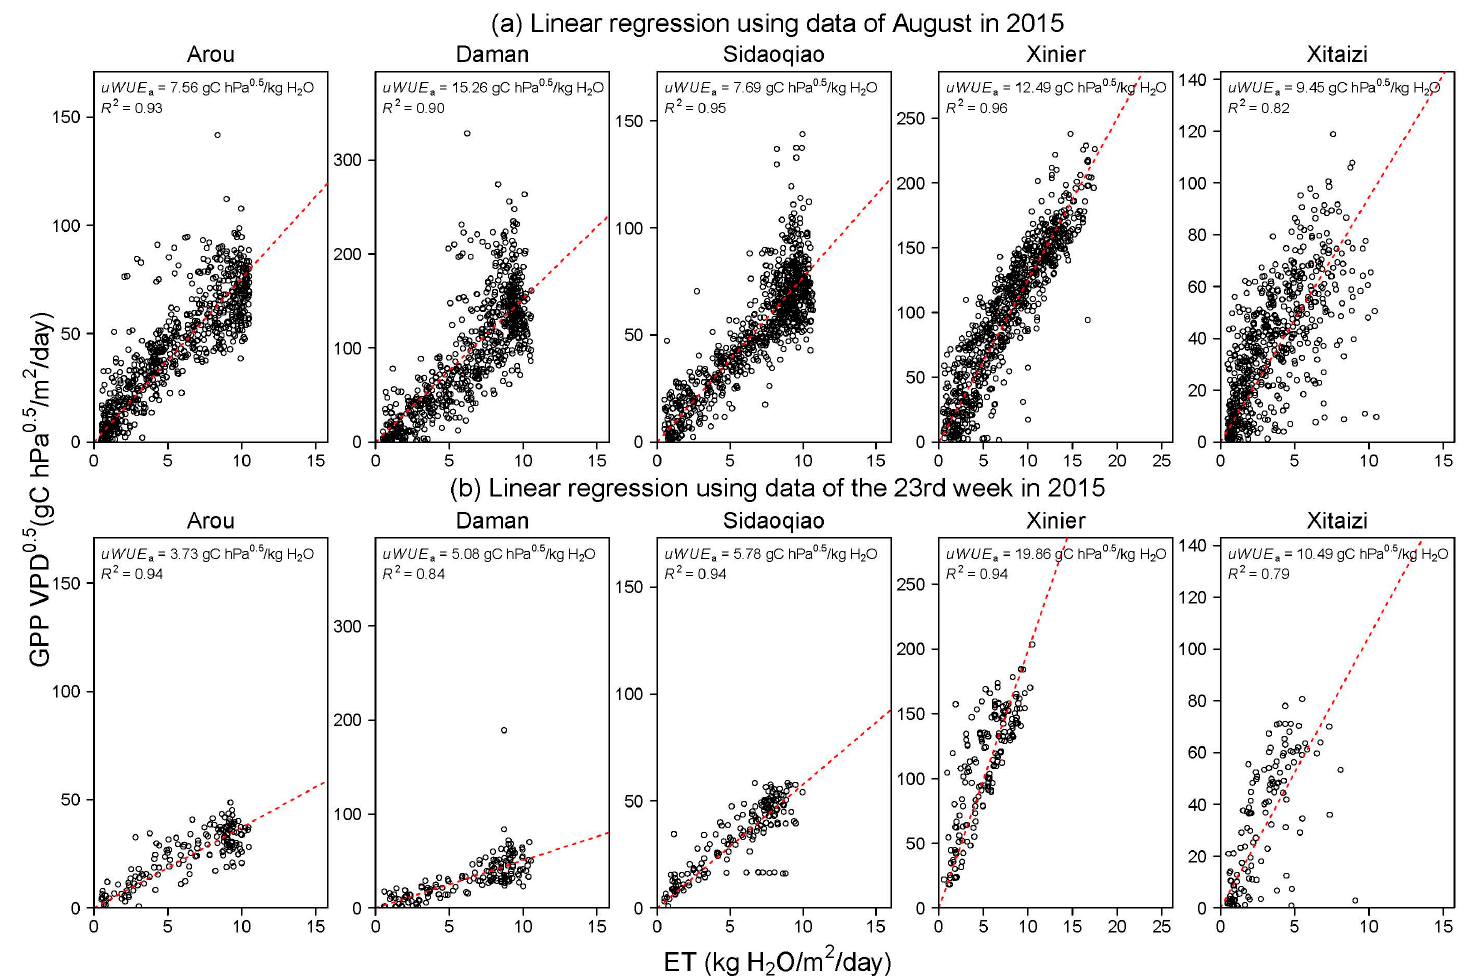
Figure 4. Linear regression using the half-hourly data for each site on a monthly and weekly scale. ( a ) is linear regression using the data of August in 2015, ( b ) is linear regression using data of the 23rd week in 2015.